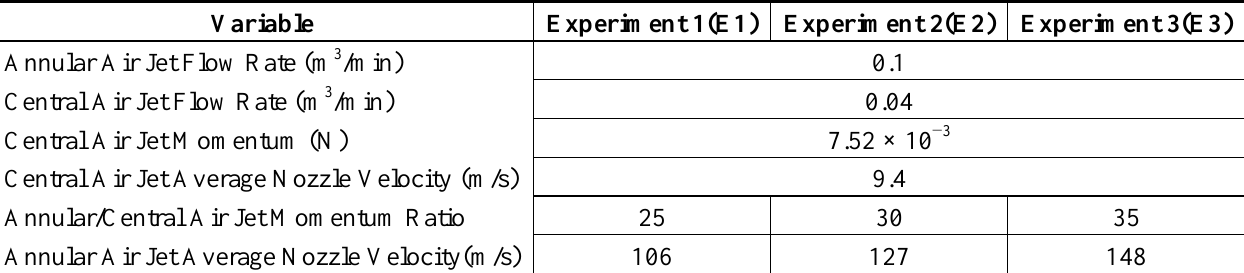
Table 2. The annular and central air jet properties used for experimental